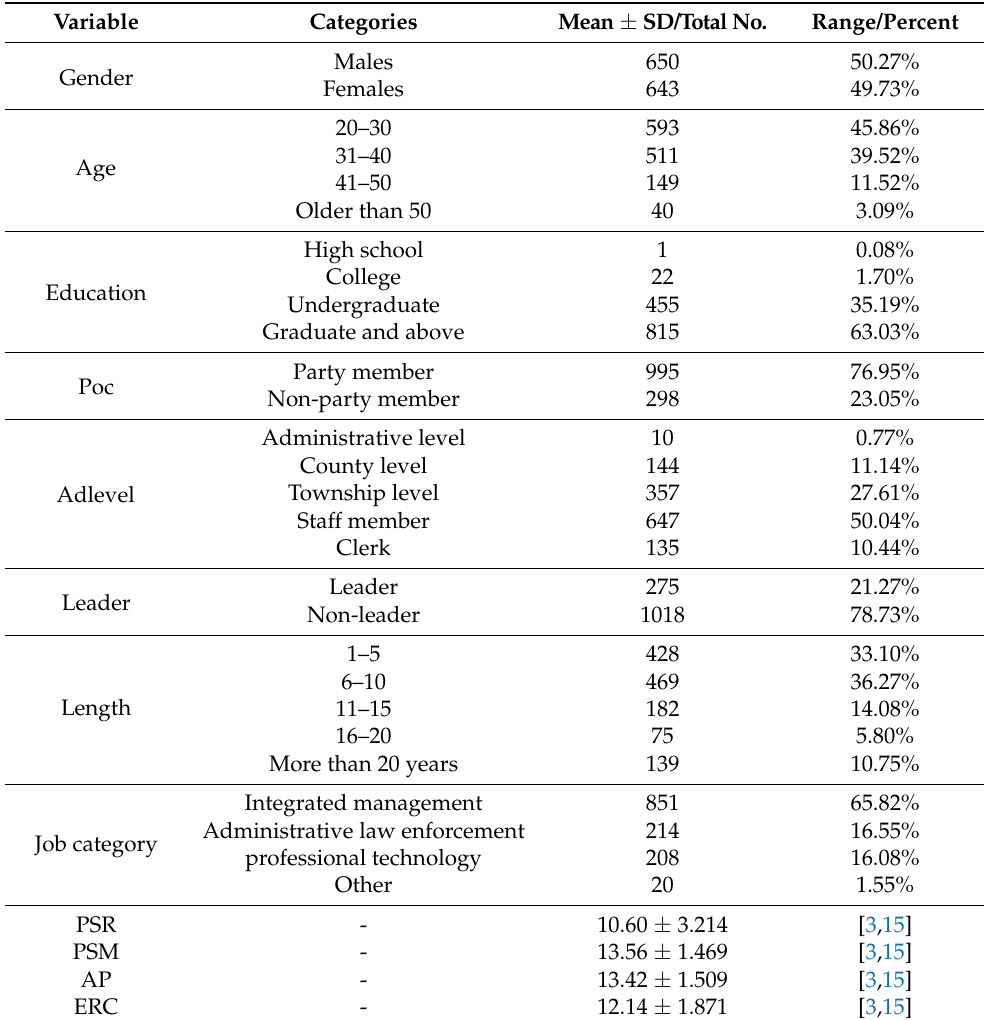
Table 2. Descriptive statistics of the variables ( n =